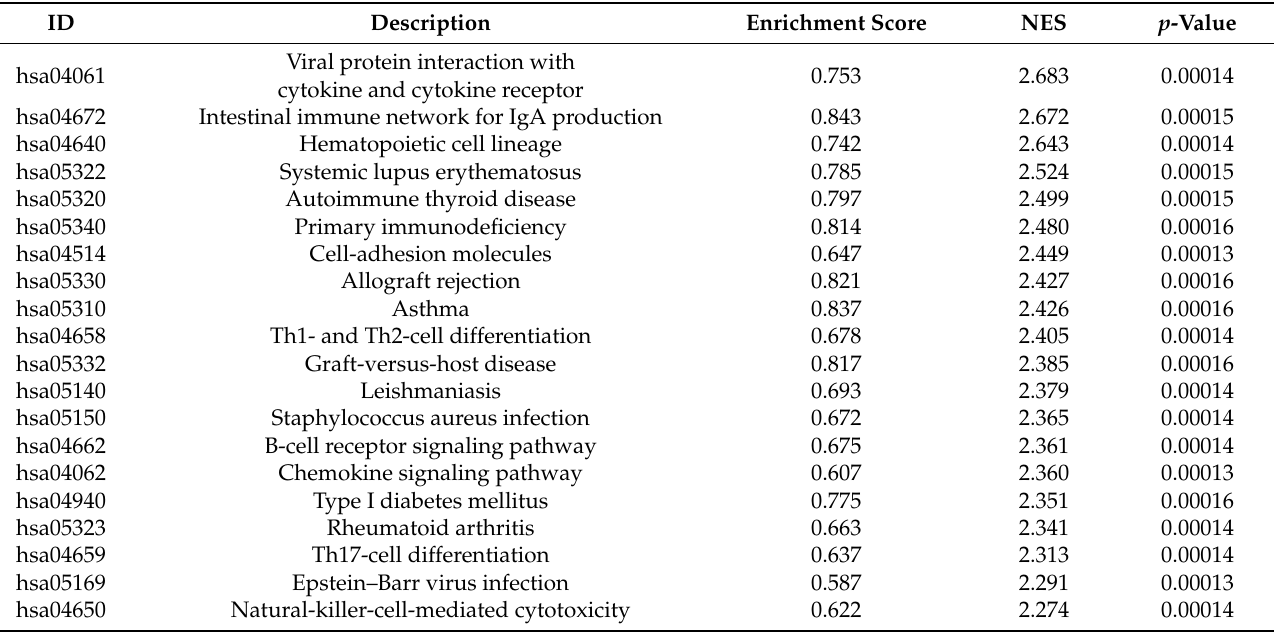
Table 3. Top 20 KEGG terms from GSEA of Hashimoto’s thyroiditis samples, ranked by Normalized Enrichment Score